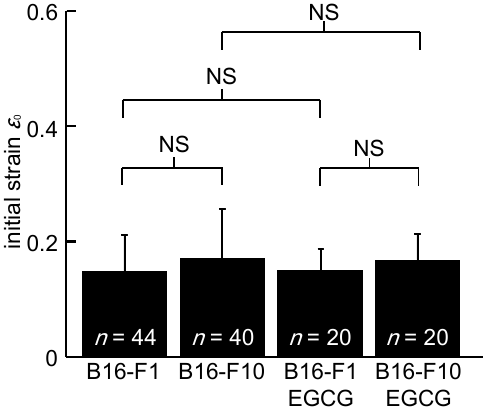
Figure 5. A comparison of the initial compressive strain, ε 0 . n : Number of cells.